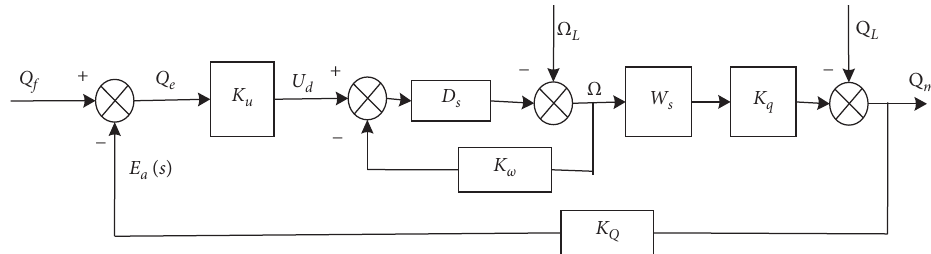
Figure 2: Block diagram of the buoyancy regulation